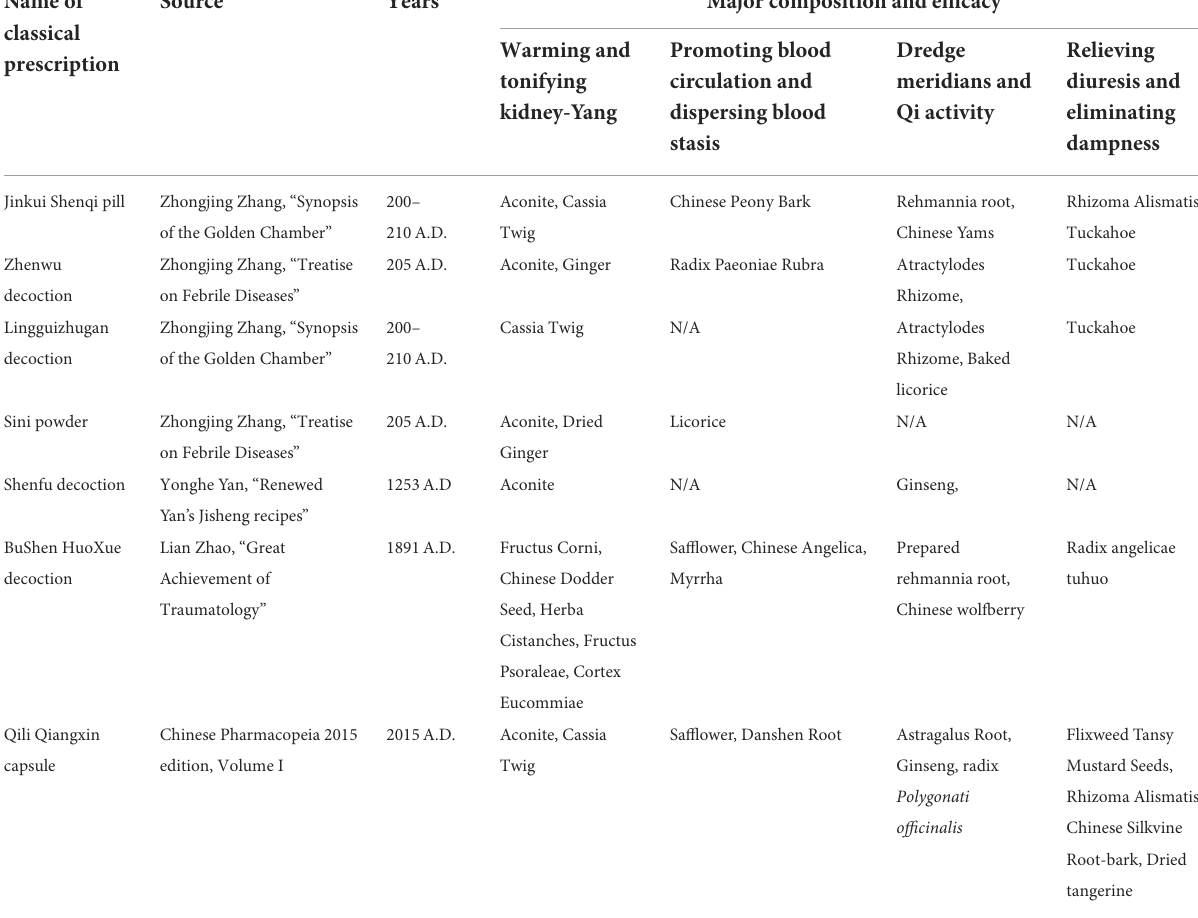
TABLE 1 Composition of several classical prescriptions for treatment of chronic heart